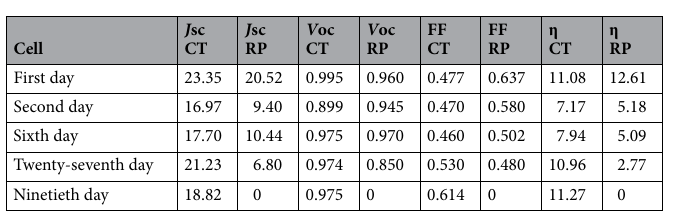
Figure 5. ( a ) J–V curve of PSCs bearing different thicknesses of CT-TiO 2 . ( b ) IPCE analysis of CIS-PSCs devices with different thicknesses of CT-TiO 2 ETL. ( c ) Nyquist plots of CIS-PSCs devices with different thicknesses of 1 layer of CT-TiO 2 ETL prepared by different withdrawal dip-coating speeds. ( d ) Compared impedance Nyquist of random porous and best templated porous.